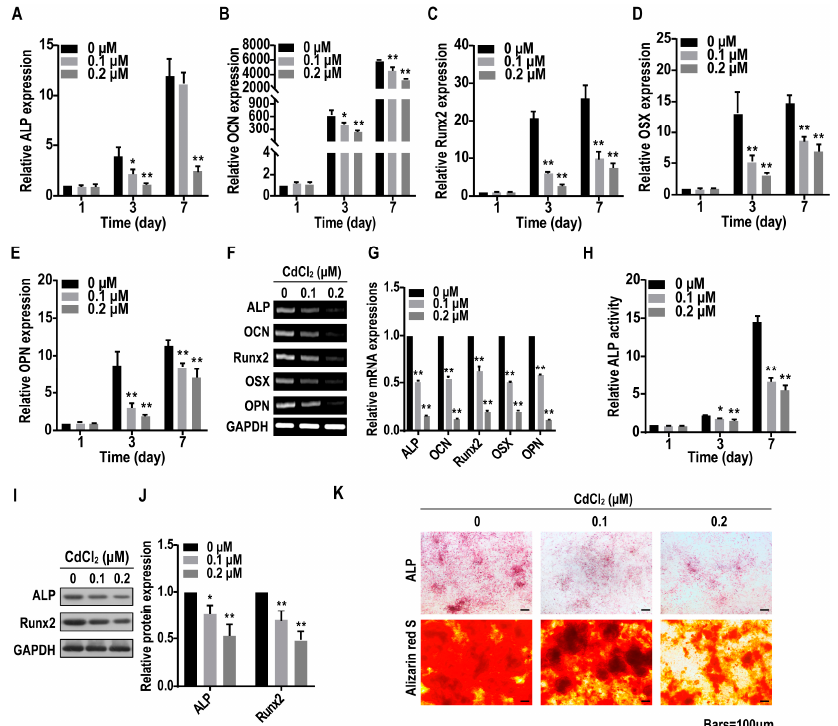
Figure 3. Cadmium inhibits the osteogenic differentiation of BMMSCs. BMMSCs were exposed to 0, 0.1, or 0.2 µM CdCl 2 for 1, 3, or 7 days. ( A – E ) The mRNA levels of the osteogenic differentiation markers, such as alkaline phosphatase (ALP) ( A ), osteocalcin ( OCN ) ( B ), runt-related transcription factor 2 ( Runx2 ), ( C ), osterix ( OSX ) ( D ), and osteopontin ( OPN ) ( E ) were measured by quantitative Reverse-Transcriptase Polymerase Chain Reaction (qRT-PCR) (mean ± SD, n = 3). * p < 0.05, ** p < 0.01, different from control BMMSCs. BMMSCs were exposed to 0, 0.1, or 0.2 µM CdCl 2 for 7 days. ( F ) and ( G ) The mRNA levels of the osteogenic differentiation markers, ALP , OCN , Runx2 , OSX , and OPN were determined by RT-PCR analysis (mean ± SD, n = 3). * p < 0.05, ** p < 0.01, different from control BMMSCs. BMMSCs were exposed to 0, 0.1, or 0.2 µM CdCl 2 for 1, 3, or 7 days. ( H ) ALP activity was detected by ALP assay (mean ± SD, n = 3). * p < 0.05, ** p < 0.01, different from control BMMSCs. BMMSCs were exposed to 0, 0.1, or 0.2 µM CdCl 2 for 7 days. ( I ) Western blots were performed, and ( J ) relative protein levels of ALP and Runx2 were determined (mean ± SD, n = 3). * p < 0.05, ** p < 0.01,